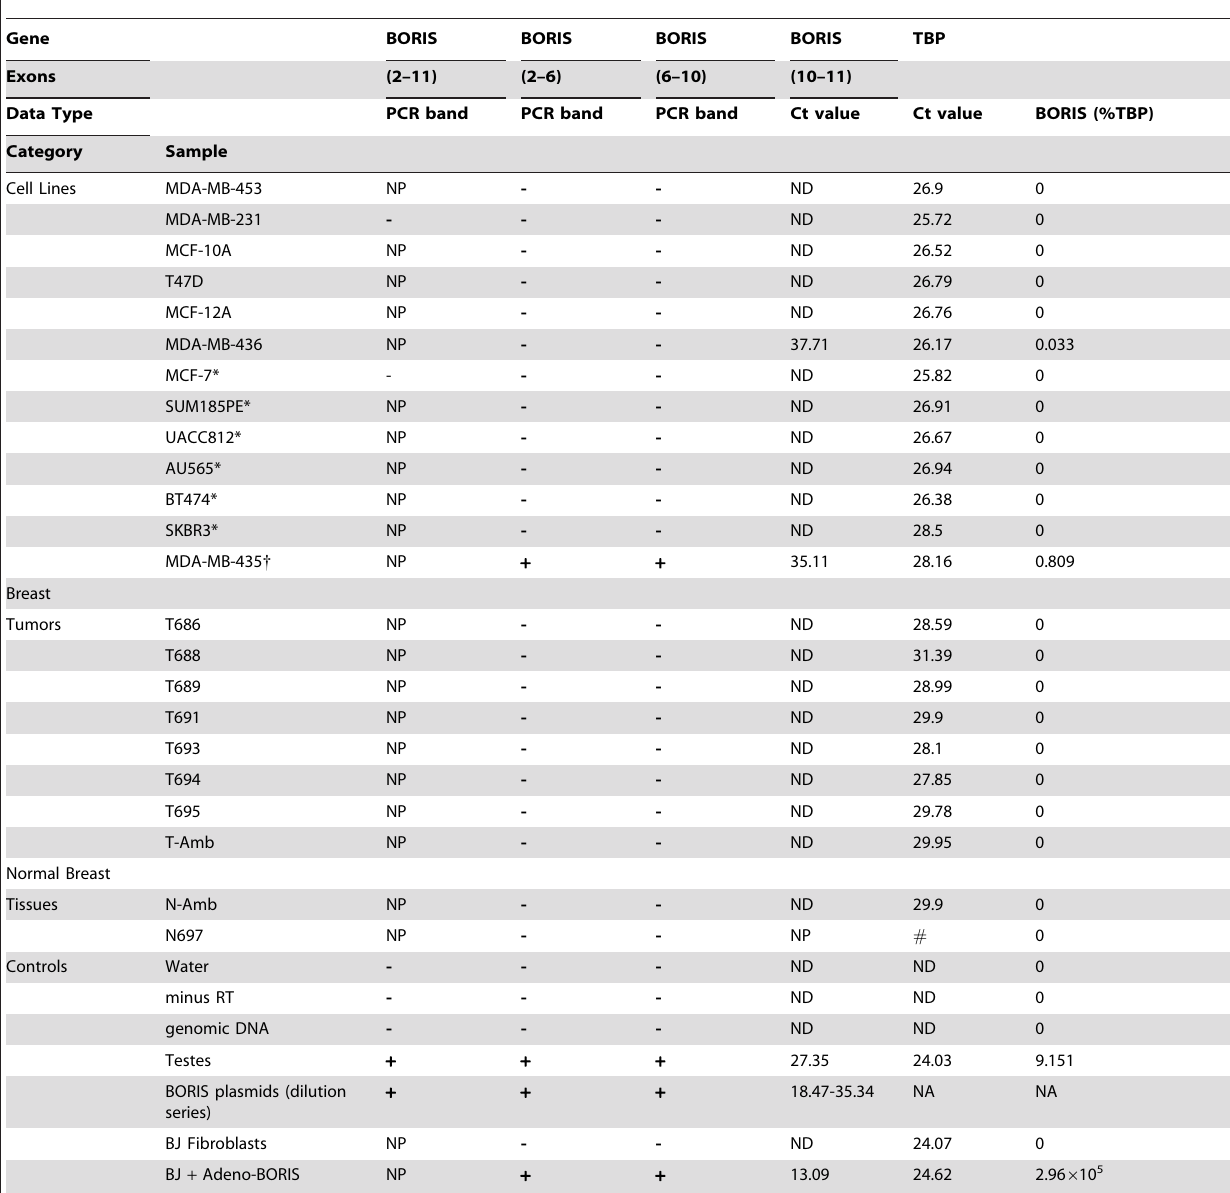
Table 1. Detection of BORIS mRNA in breast cell lines, primary tumors, and controls.